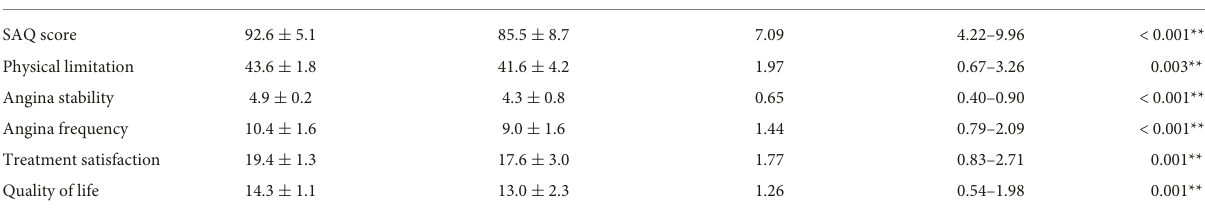
TABLE 2 The Seattle Angina Questionnaire of all patients assessed at 1